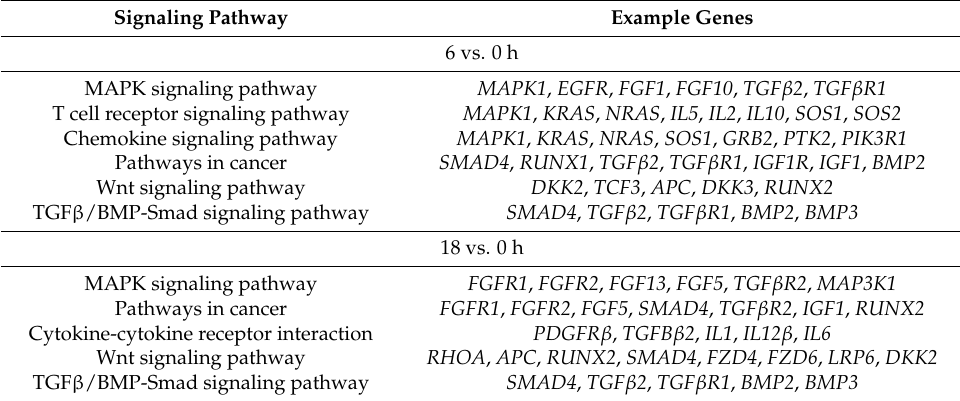
Table 2. Pathway analyses of differentially-expressed miRNA-related signaling pathways and example genes after 6 and 18 h of tensile stress